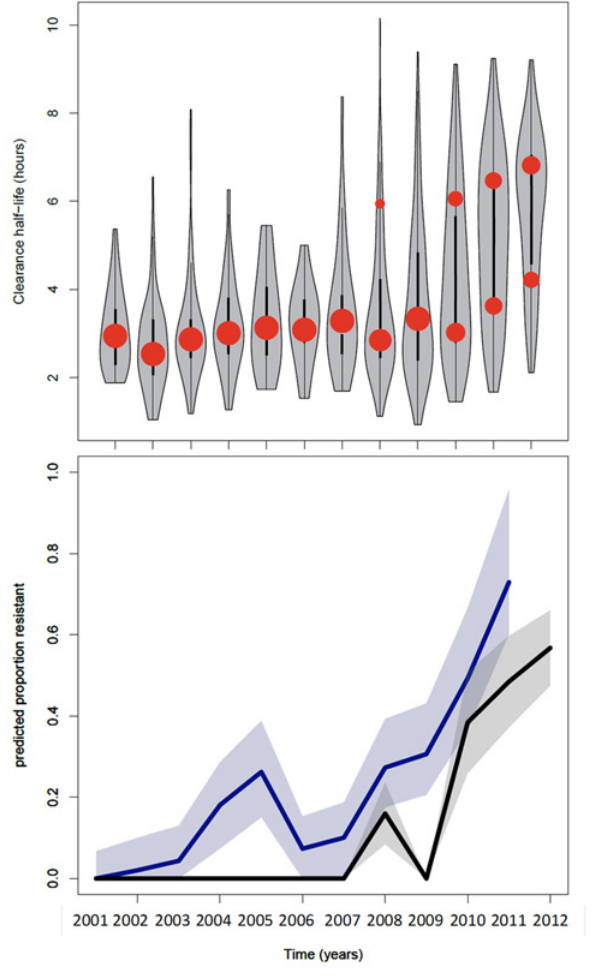
Fig 2. Summary of data from the Thai-Myanmar border and corresponding model results. Top: plot of the model fits (red dots) to observed data (grey violin plots, with a black bar representing the interquartile range) for the longitudinal study on parasite clearance after artemisinin treatment on the Thai-Myanmar border stratified by year. The number of dots per year indicates the number of contributing distributions estimated by the model. The position of the dot on the y-axis represents the geometric mean of the distribution, and the size of the dot represents the relative contribution of that subgroup to the full distribution. Bottom: plot of the predicted proportion of resistant infections (solid line) with 95% prediction interval (shaded area) using the mixture model (black) and the simulation model (blue).